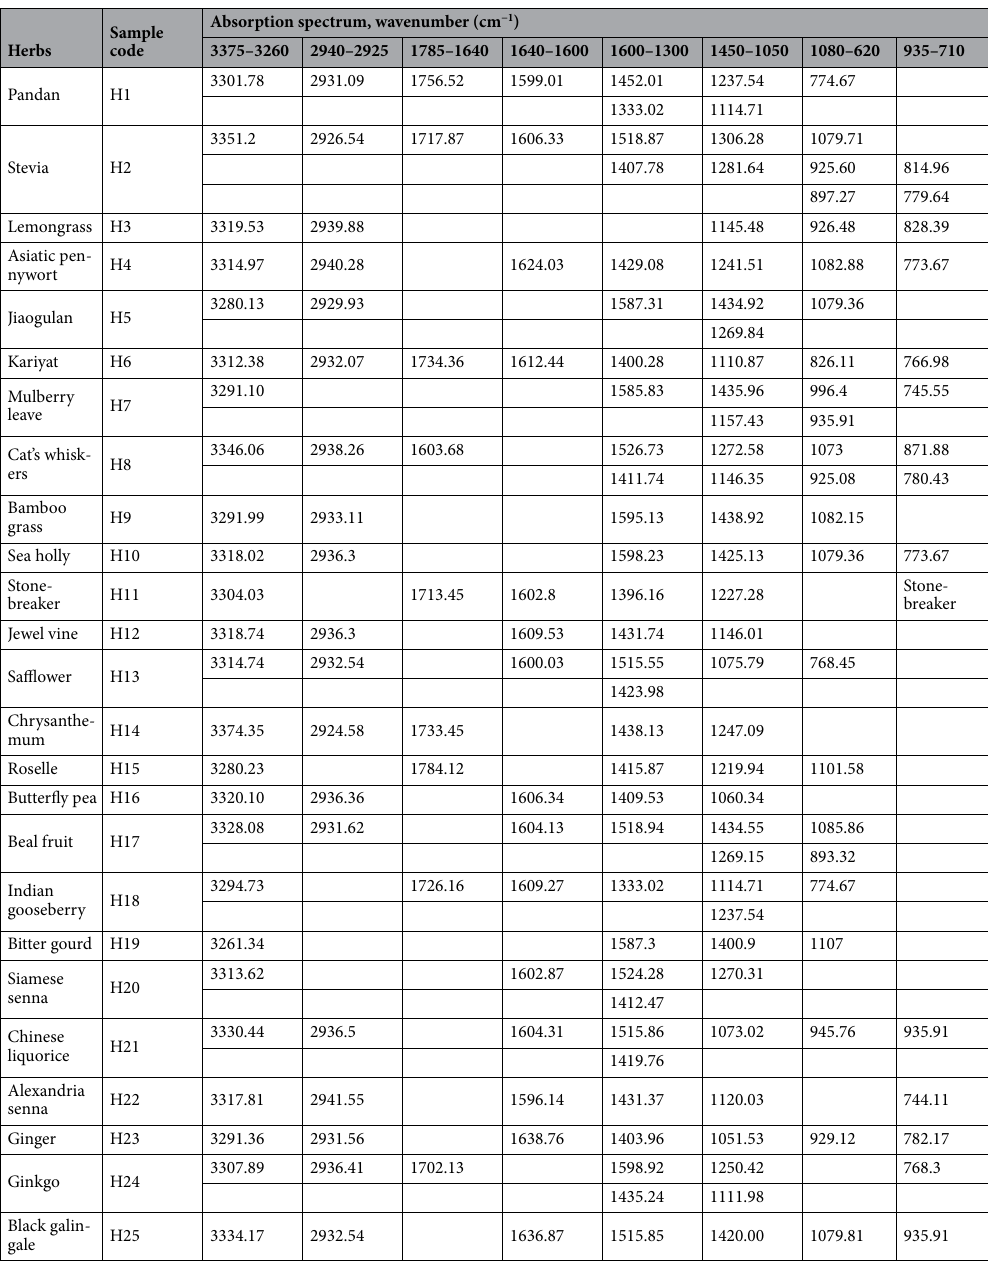
Table 1. FT-IR spectra analysis of dried herbal plant